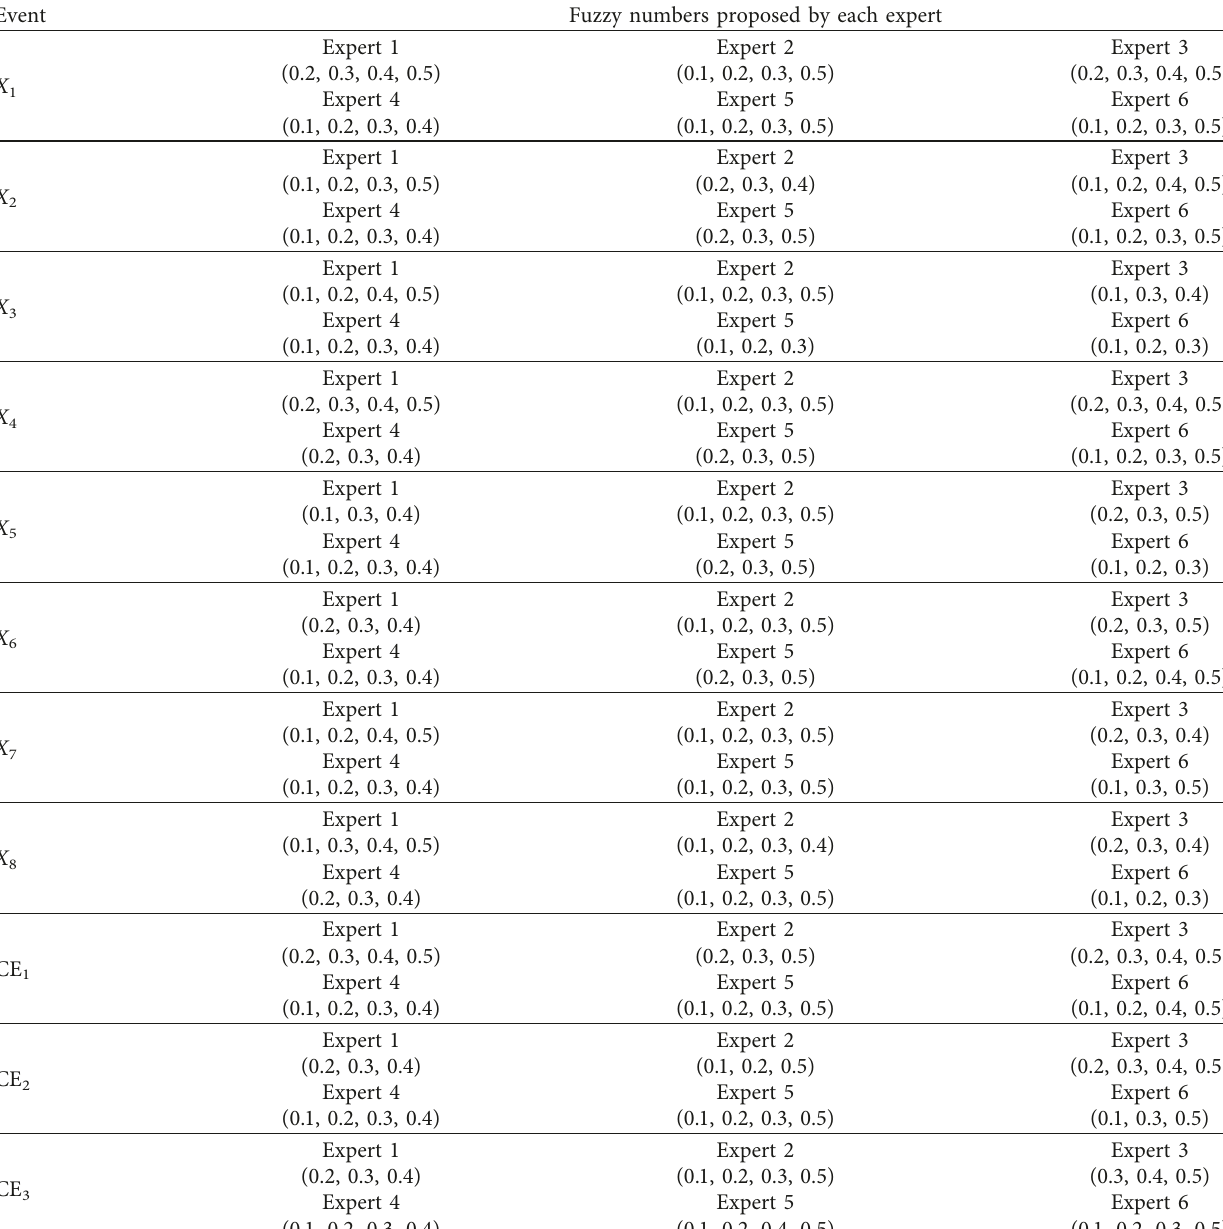
Table 13: Expert opinion on environmental failure, operational error, and multiple